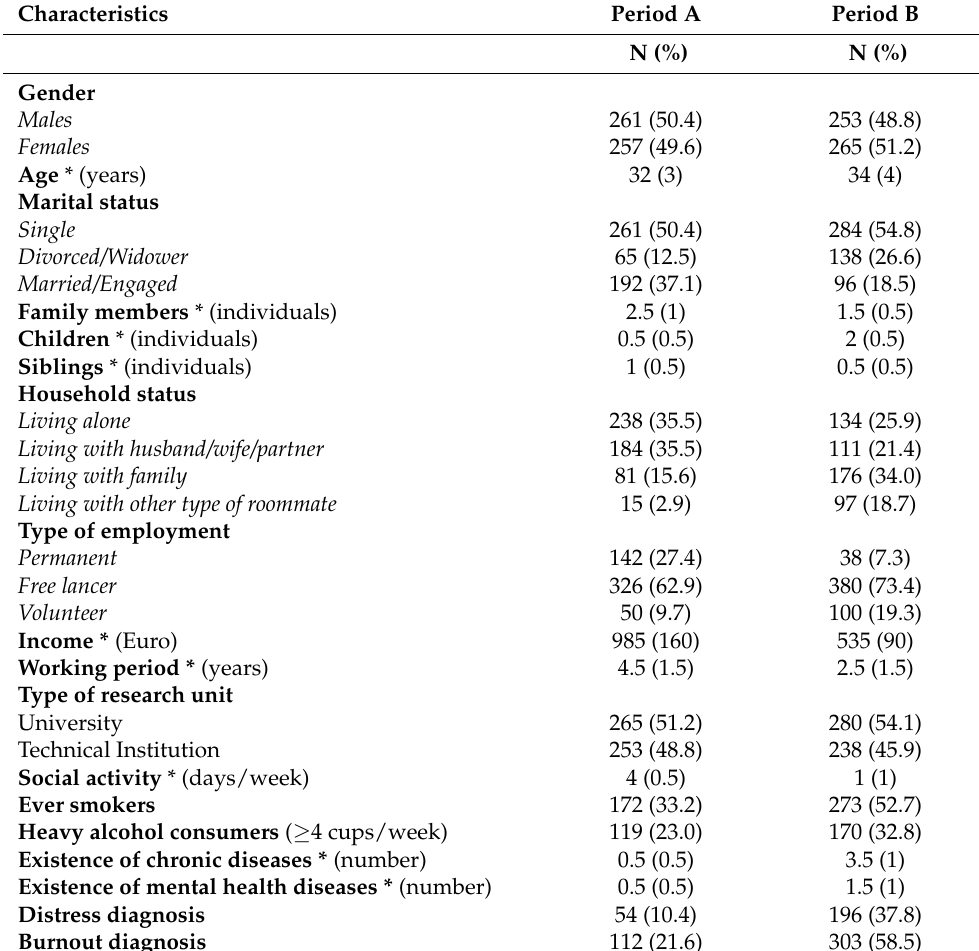
Table 1. Participants’ socio-demographic profile (n =